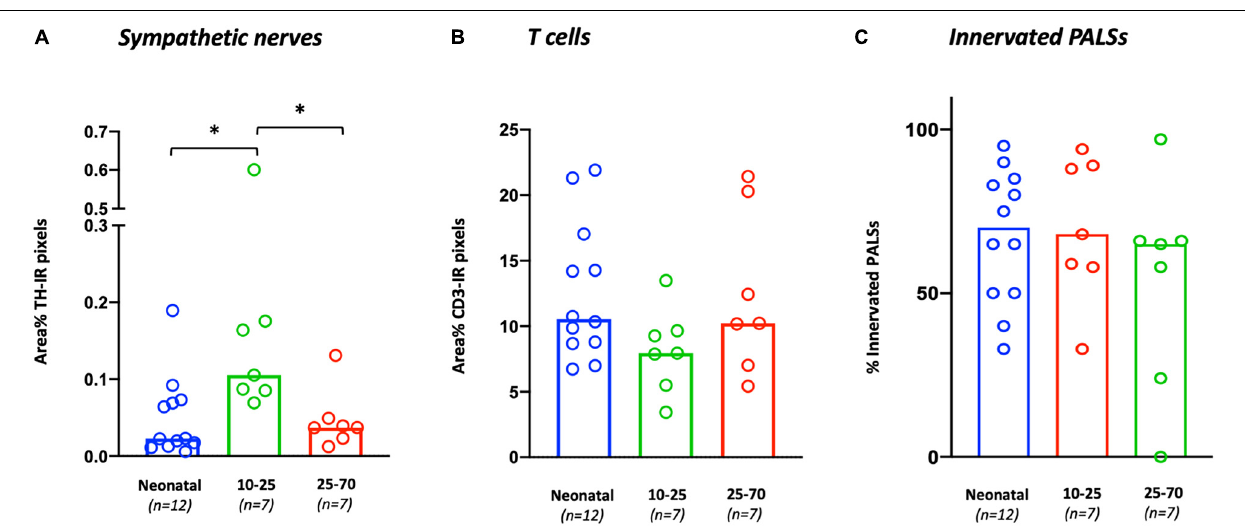
FIGURE 2 | Age-related variations in general T cell and sympathetic nerve presence and the percentage of innervated PALS. (A) The general presence of sympathetic nerves per sample is calculated as the number of TH positive pixels and expressed as area % with respect to the total area of each sample. (B) The general presence of T cells per sample is calculated as the number of CD3 positive pixels and expressed as area % with respect to the total area of each sample. (C) The number of sympathetic innervated PALSs per sample expressed as percentage of the total selected number of PALSs in each sample. ∗ P <